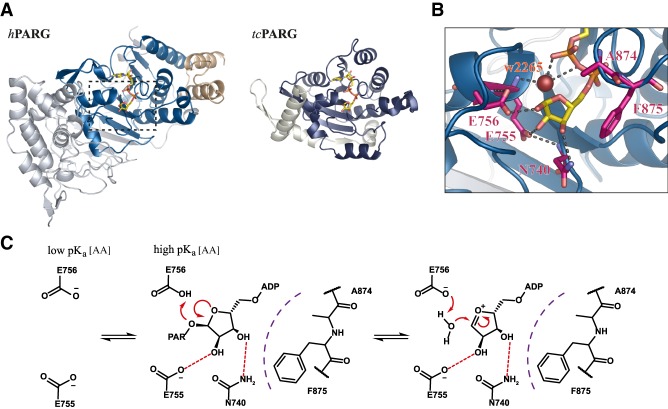
PAR degradation by PARG-like hydrolases. (A) Ribbon representation of the catalytic domains of canonical PARGs (depicted hPARG; PDB 4B1H) and microbial PARGs (depicted tcPARG; PDB 3SIG) in complex with ADPr. (B) Close up of the active site of hPARG. (Yellow) ADPr; (magenta) residues involved in ligand orientation and catalysis; (red) structural water (w2265); (dashed lines) selected polar interaction. (C) Potential reaction mechanism for PARG-like enzymes. Residue numbering is in accordance with human PARG111.